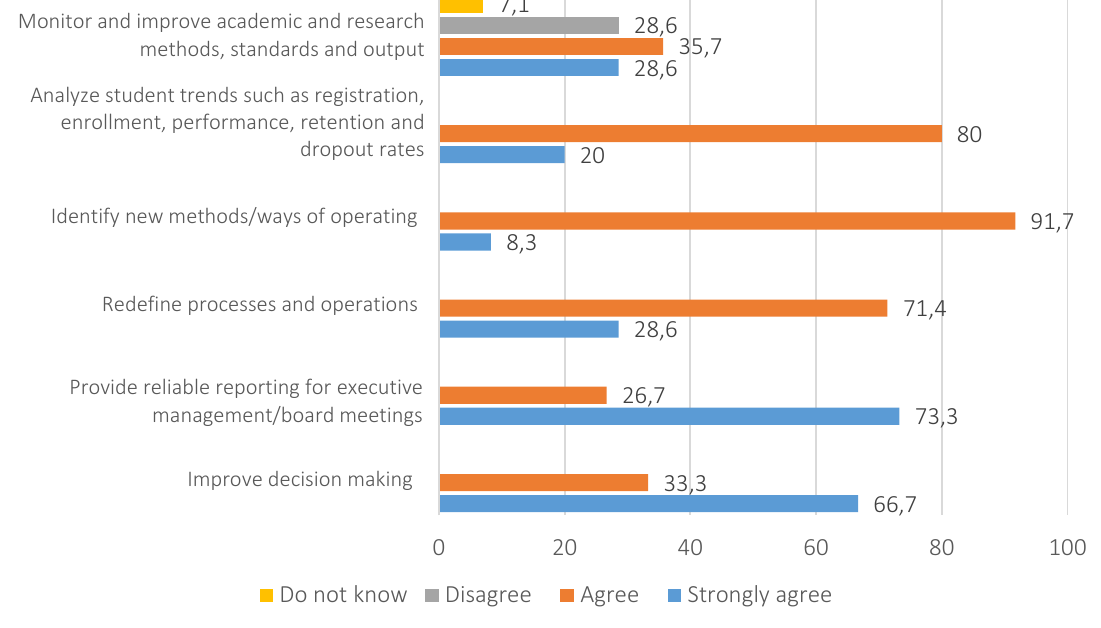
Figure 4. Strategic use of knowledge management